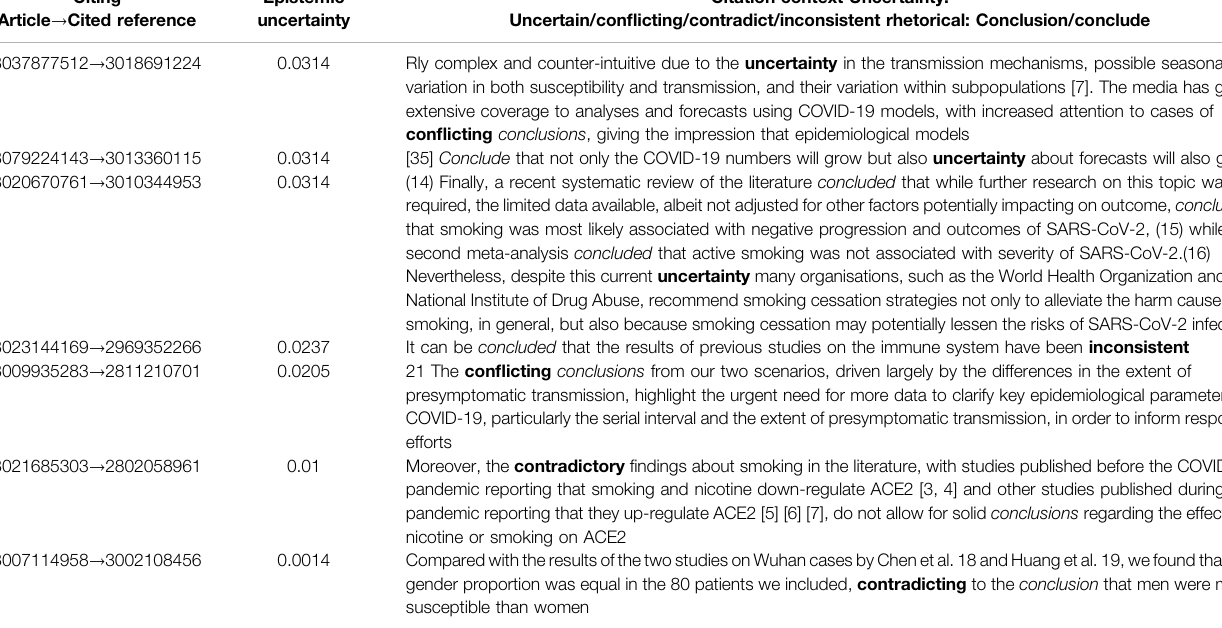
TABLE 3 | Epistemic uncertainties of citation contexts containing speci fi c rhetorical words on conclusions.